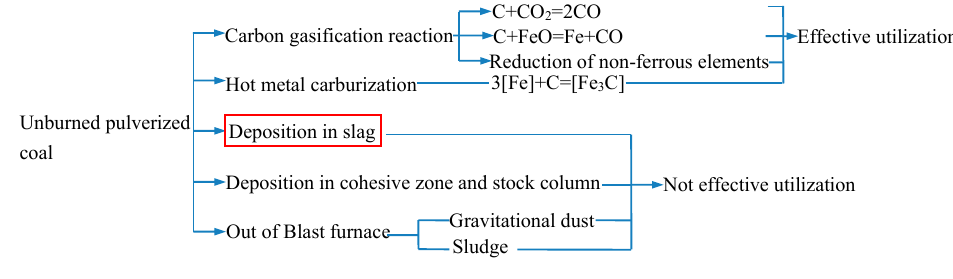
Figure 2. Behavior of UPC in a BF.